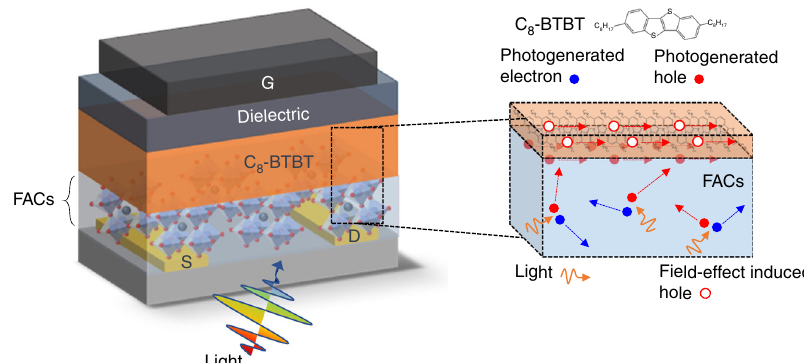
Fig. 5 Operational mechanism for FACs/C 8 -BTBT type-I HJPTs. Illustration of the photocarrier transport mechanism in the type-I HJPT using the FACs/C 8 - BTBT fi lm stack where G, S and D denote the gate, source and drain electrodes, respectively. The photogenerated holes excited by light illumination can diffuse and/or accumulate at/near the FACs/C 8 -BTBT interfaces under the in fl uence of a weak gate fi eld-effect and transport along the C 8 -BTBT transistor channel formed of organic molecules packed in an edge-on orientation, resulting in the enhanced photoresponse at/near the